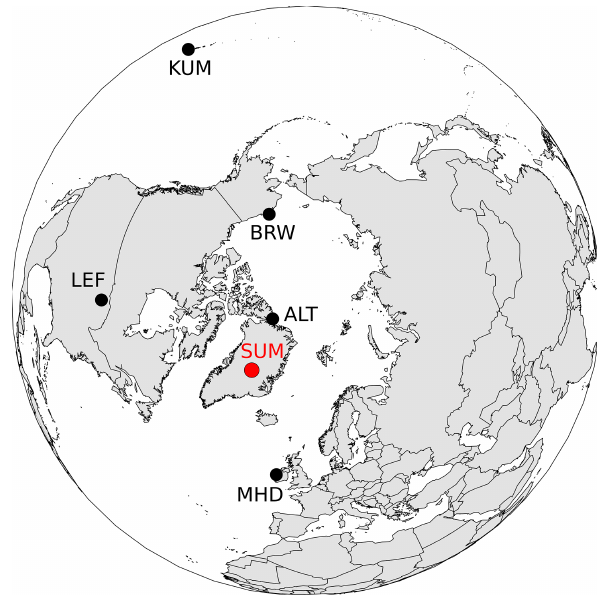
Figure 1. Location of the Greenland Environmental Observatory at Summit station (red dot, SUM) where long-term in situ mon- itoring was carried out and of Alert (ALT), Utqia˙gvik (formerly known as Barrow (BRW)), Mace Head (MHD), Park Falls (LEF), and Cape Kumukahi (KUM), where discrete samples were collected by both the NOAA/ESRL/GML CCGG and HATS flask sampling programs. The map is centered over the North